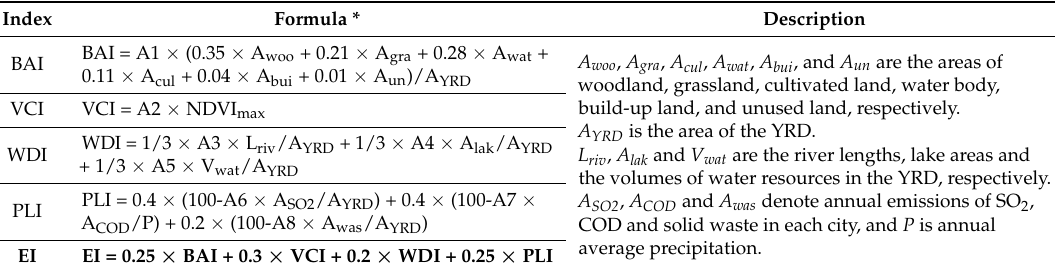
Table 1. Calculation methods of EI and its